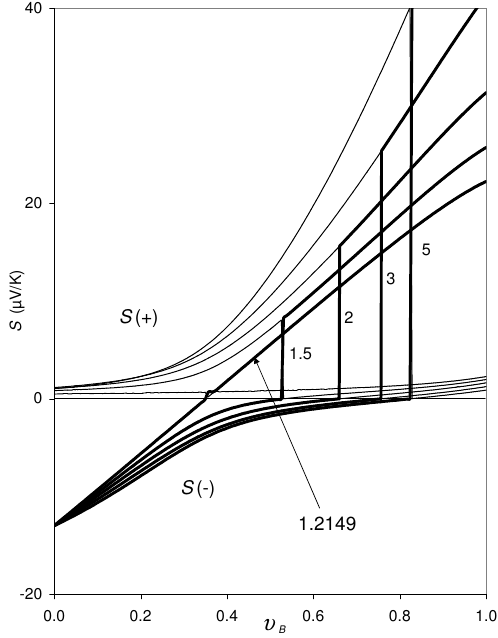
Figure 3. Same as Figure 2, for varying values of p : p = 1.5, 2, 3, and 5 (in units of 10 22 cm − 3 ), while ∂ E C , A / ∂ T = ∂ E V , B / ∂ T = ∂ϕ i / ∂ n i = 0 is set. The discontinuity in the curves shifts to lower υ B as p decreases. For p < 1.2149 × 10 22 cm − 3 (and n = 10 22 cm − 3 ), Equation (9) does not have real solutions for the entire concentration range. For p > 1.2149 × 10 22 cm − 3 the lower kink of S ( ± ) at the discontinuity occurs always at S ( − ) = S (+) =